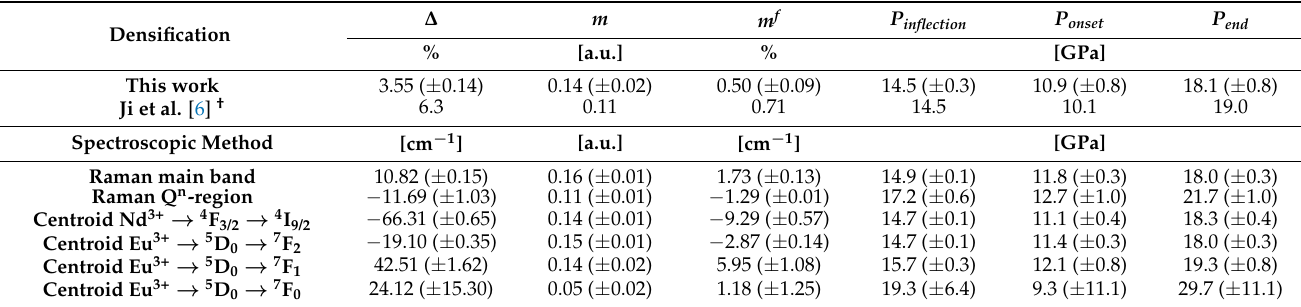
Table 1. Sigmoidal fitting parameters (Equation (5)) for densification and various spectroscopic methods in relation to the centroid σ versus P max